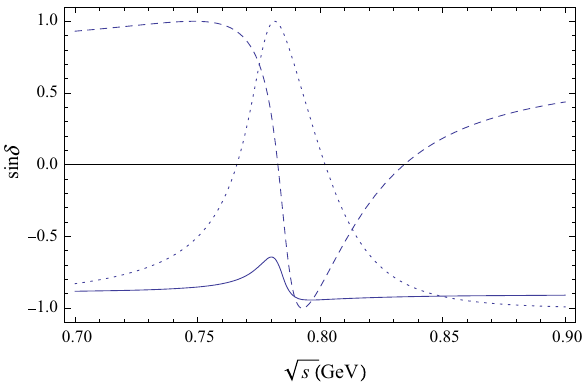
√ s = 0 . 76 GeV, the CP violating asymmetry varies When from around 20 . 63% to around 34 . 64%. Here the first uncer- tainty corresponds to the CKM parameters, the second comes from the hadronic parameters, and the third is associated with the hard